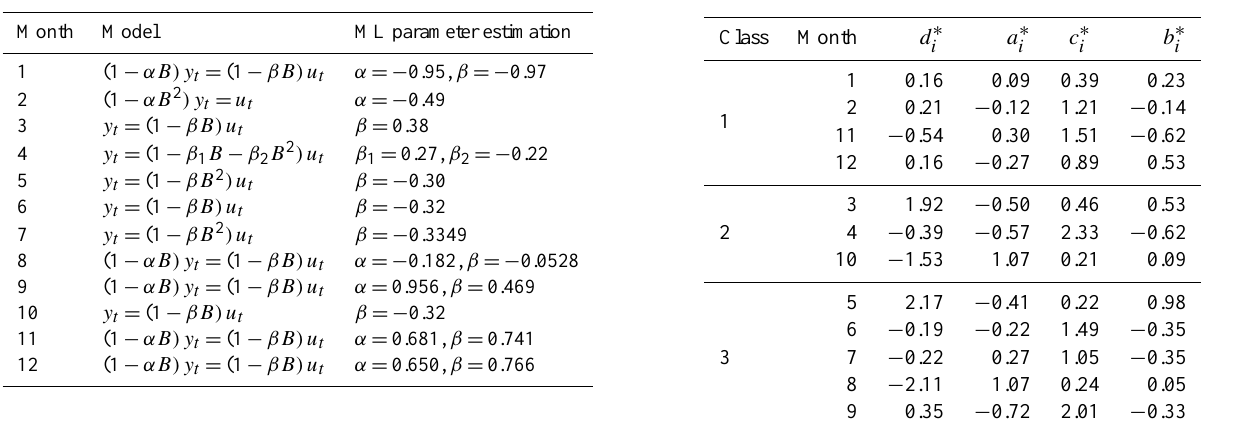
Table 3. Seasonal ARIMA models for each month. Table 4. Estimated parameters for linear regression models.